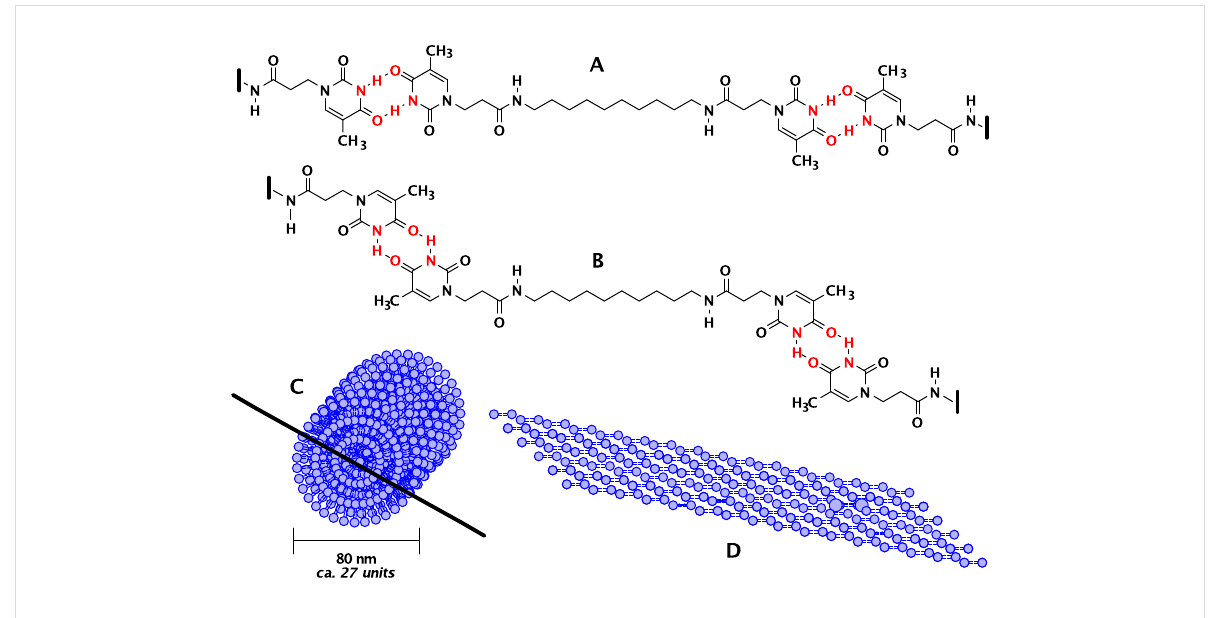
Figure 5: Models of micro- and nanofibres based on hydrogen bonding interactions between thymine units; ( A ) thermodynamically favourable linear system of hydrogen bonds; ( B ) less favourable “bent” system of hydrogen bonds; ( C ) π -stacking and hydrogen bonding based nanofibre; ( D ) longitud- inal cross-section of a particular nanofibre.